Question: What style of plot is this figure drawn as?
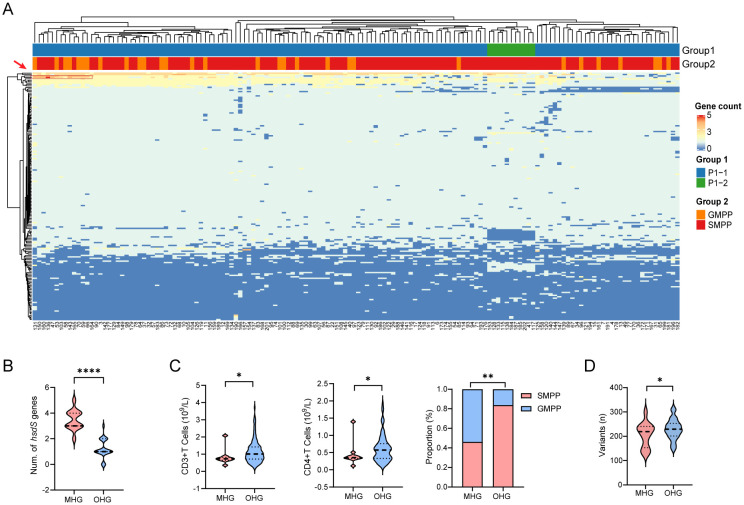
Answer: heatmap